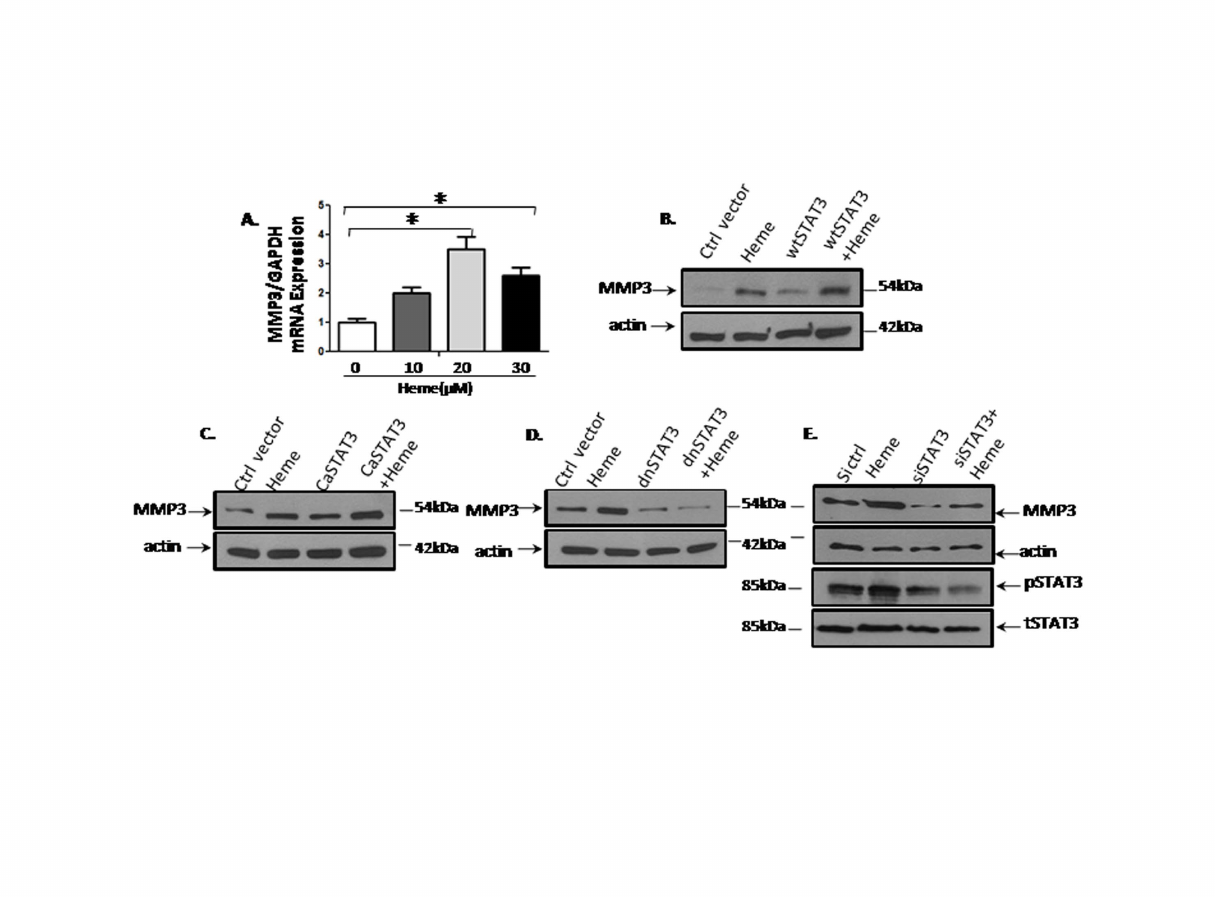
Figure 5. STAT3 transcribes MMP3 and induces MMP3 protein production in HBVEC cells. STAT3 activation of MMP3 has not been previously reported. Therefore, we sought to detect whether STAT3 transcribes MMP3. We stimulated HBVEC cells with Heme, and determined mRNA and protein levels of MMP3 by using qRT-PCR and Western blot. Consistent with the observation that Heme upregulated protein levels of MMP3 as shown in Figure 2A, Heme upregulated mRNA levels of MMP3 in Figure 5A. We then determined whether STAT3 regulates MMP3 using a STAT3- inducible model in HBVEC cells. To this end, HBVEC was transfected with 1 m g of constitutively active STAT3 (caSTAT3), dominant negative STAT3 (dnSTAT3), wild type STAT3 (wtSTAT3) as well as control vector for 24 h. Protein lysates were then made to probe with anti-MMP3 antibody. The results indicate that wtSTAT3 (Figure 5B) and caSTAT3 increased MMP3 expression (Figure 5C) whereas dnSTAT3 reduced MMP3 expression (Figure 5D). When pSTAT3 is reduced by siSTAT3, MMP3 protein expression was inhibited (Figure